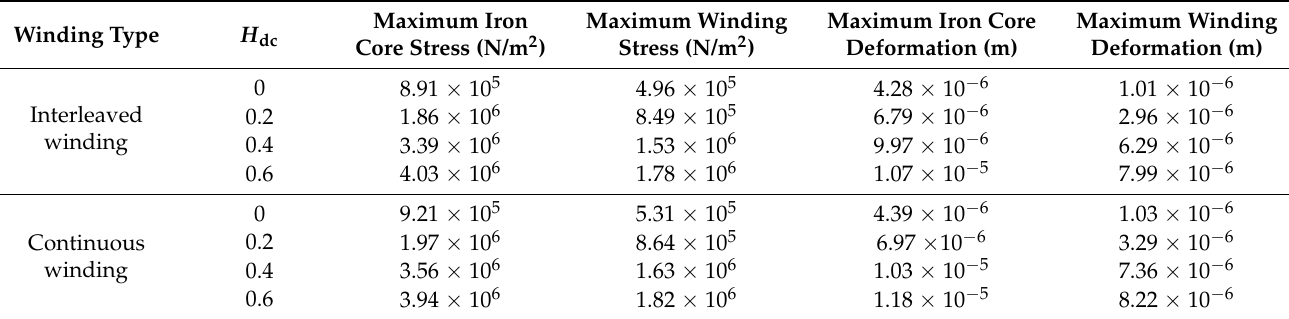
Table 4. Vibration parameters with different DC